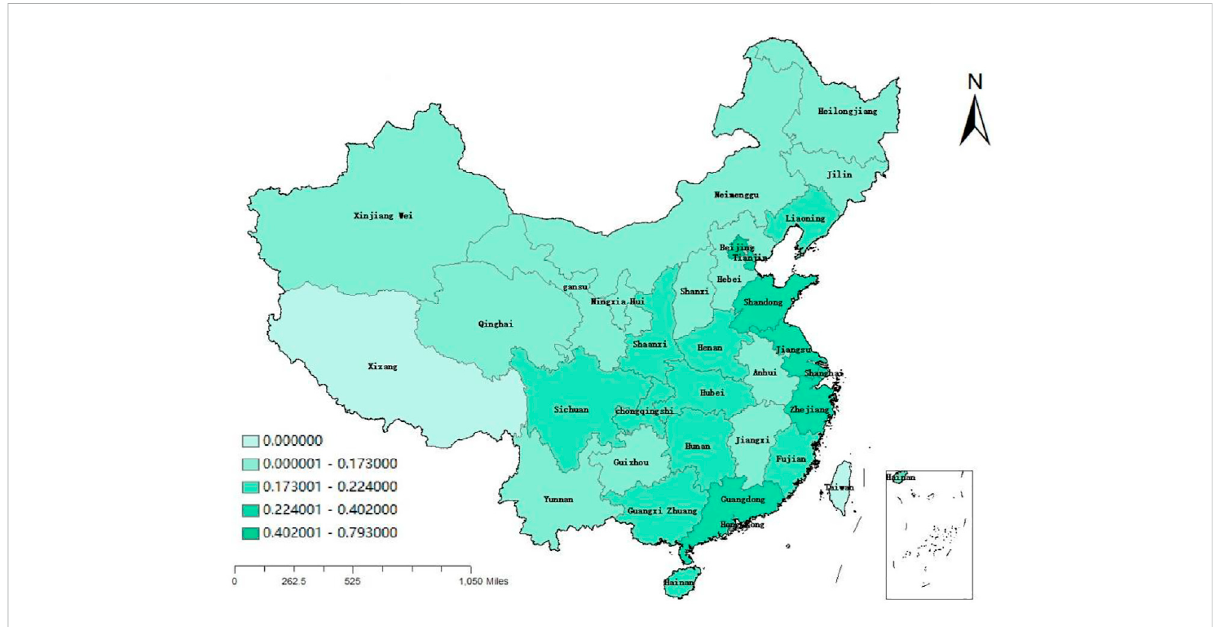
FIGURE 2 2019 Green fi nance index distribution map.